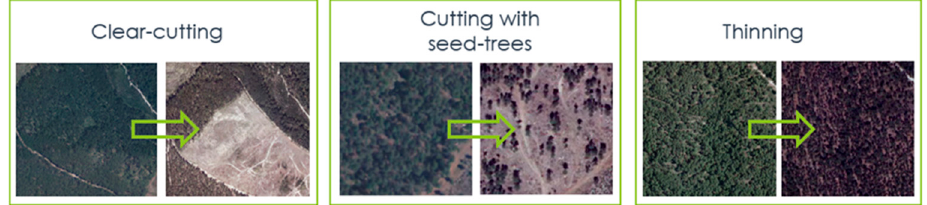
Figure 2. Number of scenes used per year analyzed with BFAST, and visualization of historic and monitoring periods. Two scenarios are considered to assess how ALS data may help characterizing change. In scenario A , ALS metrics are available at the end of the monitoring period ; in scenario B , ALS metrics are available at the beginning of the monitoring period .